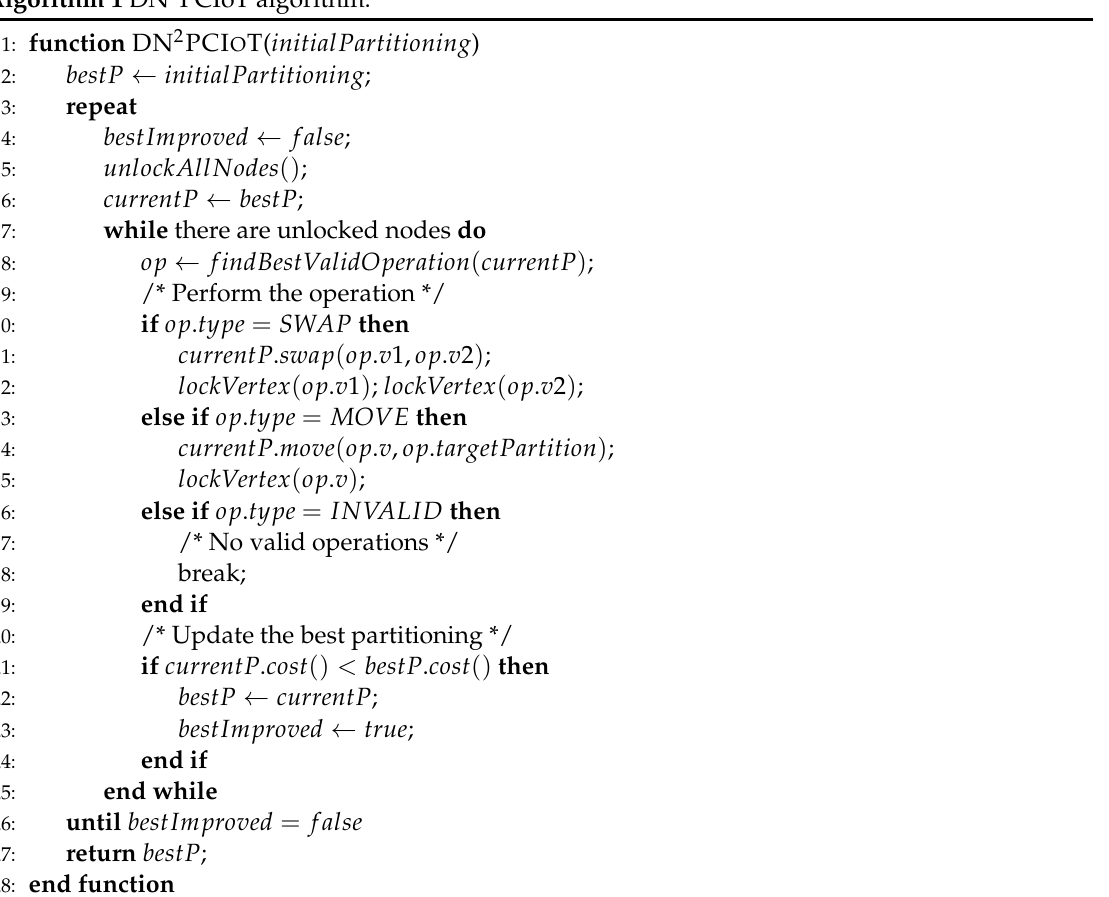
Algorithm 1 DN 2 PCIoT